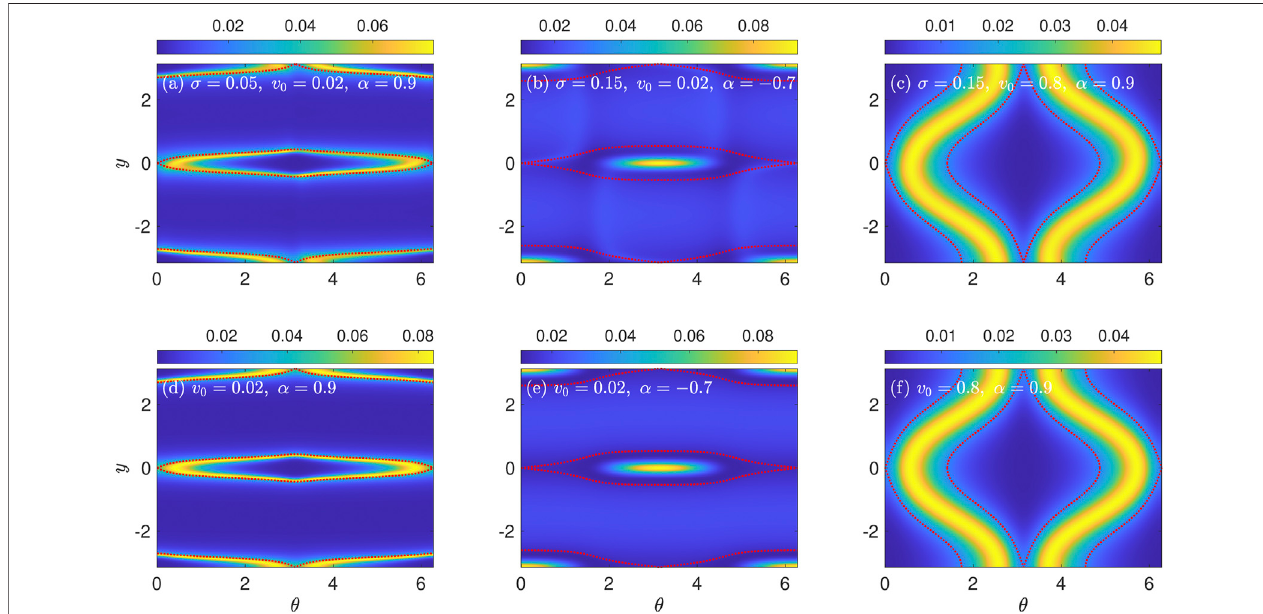
FIGURE 10 | Comparison of (A – C) the phase-space distributions with the rotational slowdown effect fi ltered out, P ( y , θ ) (1 − α cos2 θ ), with (D – F) the distributions P 0 ( y , θ ) (1 − α cos2 θ ) predicted by the averaging model given in Eq. 40